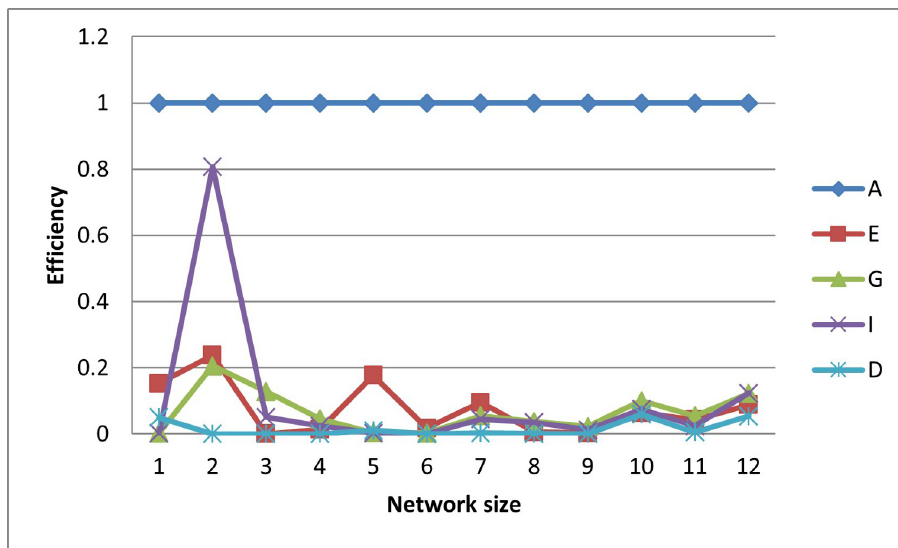
Fig 16. A-efficiencies of various optimal designs for the second case